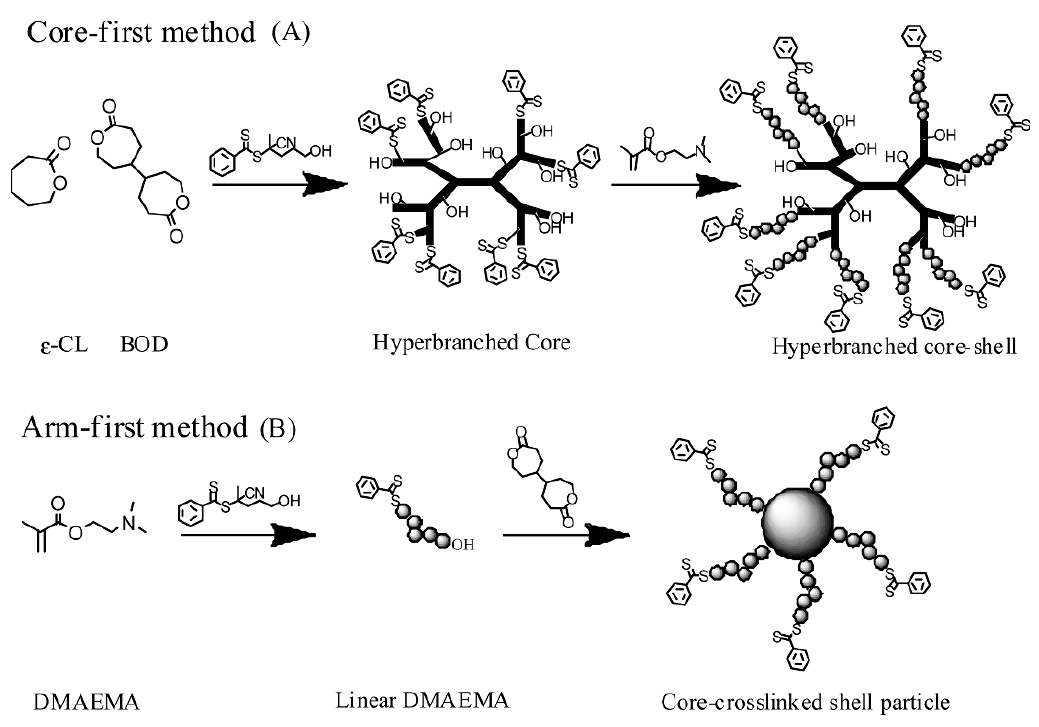
Figure 5. Scheme of degradable core–shell polymer via RAFT and ROP route. Routes ( A , B ) demonstrate the core-first method (for hyperbranched particles) and arm-first method (for CCS particles), respectively. Copyright 2011, American Chemical Society.